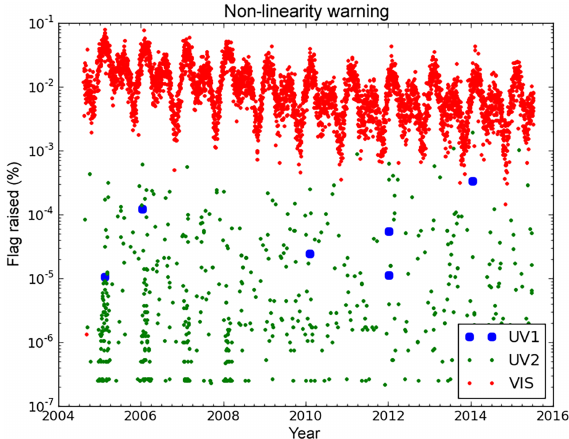
Figure 11. Non-linearity comparison for the UV channel for dif- ferent years. Apart from the 2005/04 curve, the curves are pretty similar, which indicates that non-linearity has not changed much during the mission. The curves for the VIS channel are similar to the UV channel